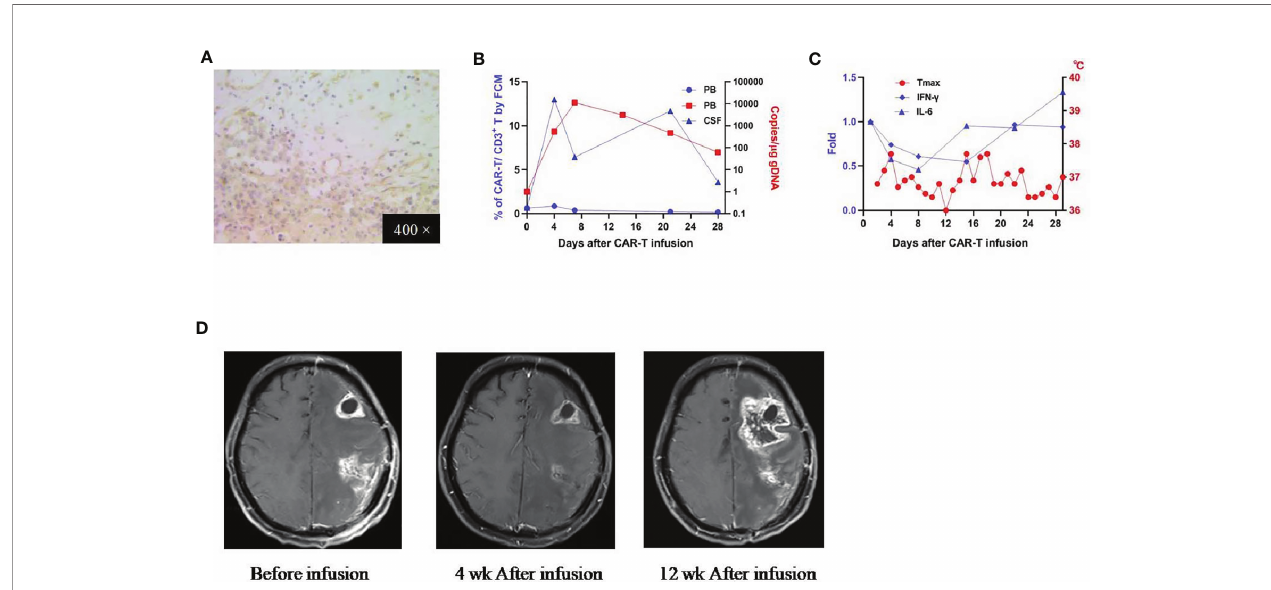
FIGURE 3 | IHC staining of the tumor and clinical response in patient 2. (A) Anti-EphA2 IHC staining of tumor tissue before enrollment. (B) Expansion of CAR T-cells in the peripheral blood by fl ow cytometry (left y-axis) and qPCR (right y-axis). (C) Dynamic changes of critical cytokines in the peripheral blood along with temperature, after the infusion of CAR T-cells. (D) Contrast-enhanced brain MRI performed before and 4 weeks,12 weeks after the infusion of CAR